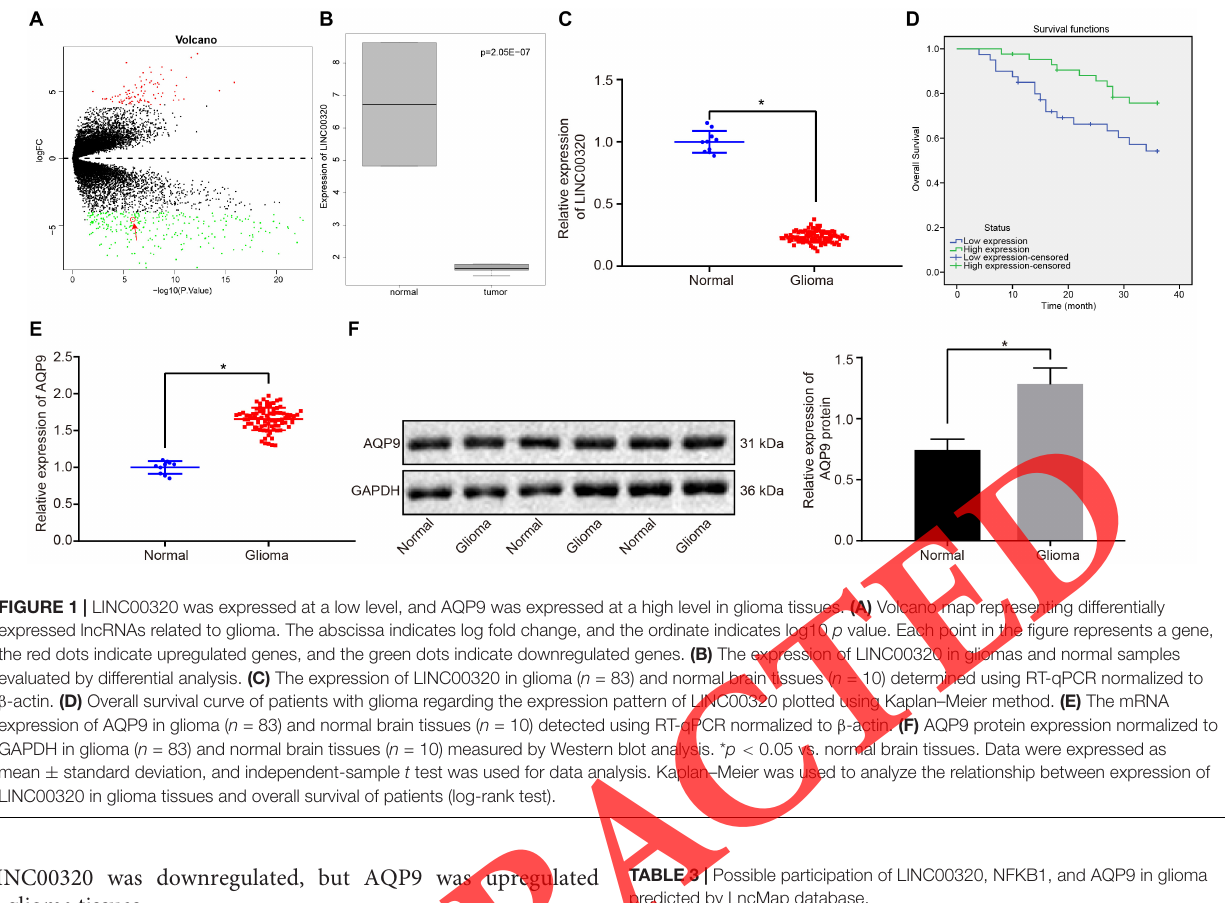
TABLE 3 | Possible participation of LINC00320, NFKB1, and AQP9 in glioma predicted by LncMap database. Cancer